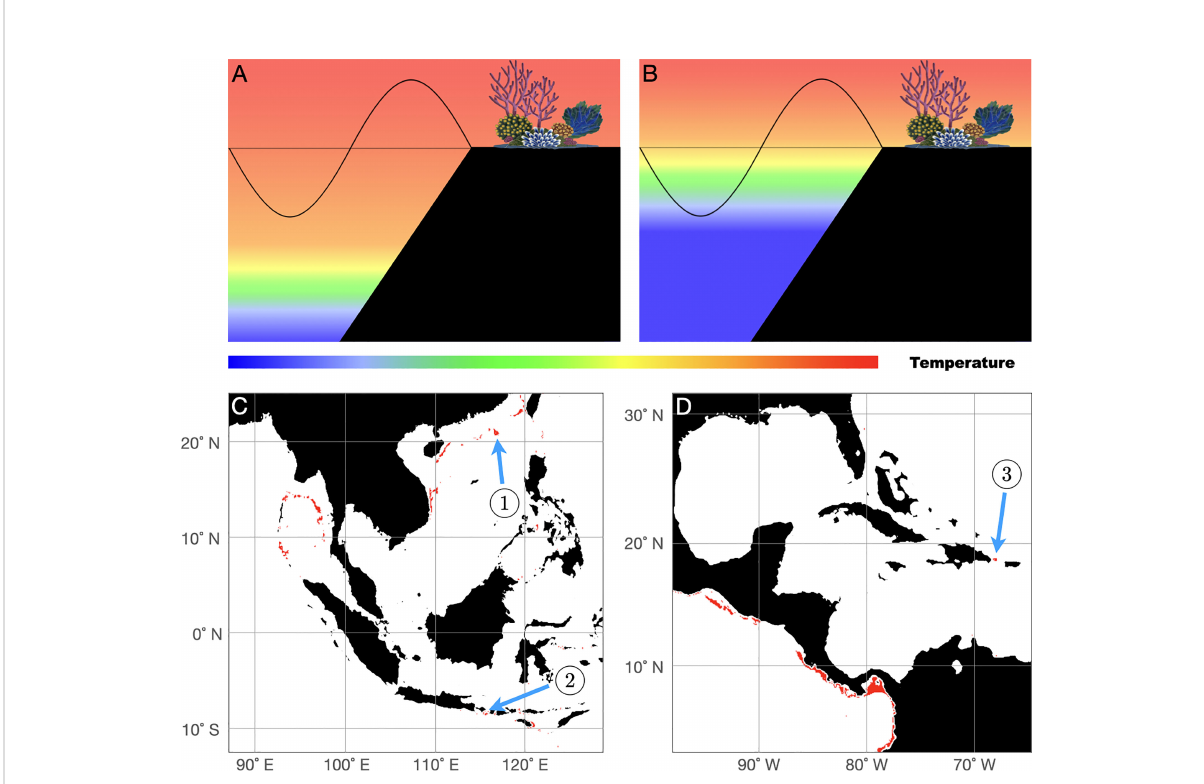
FIGURE 4 (A) A tidally-generated internal wave near a shallow water coral reef oscillates over a smaller range of temperatures when the mixed layer is deep versus (B) when it is shallow. (C, D) Selected locations where the difference between the maximum and minimum monthly-averaged daily range in temperature at 10 m depth exceeds 1°C, indicated in red. Speci fi c locations highlighted in Figure 5 are indicated by blue arrows. ① : Dongsha Atoll; ② : Lombok Strait; ③ : Mona